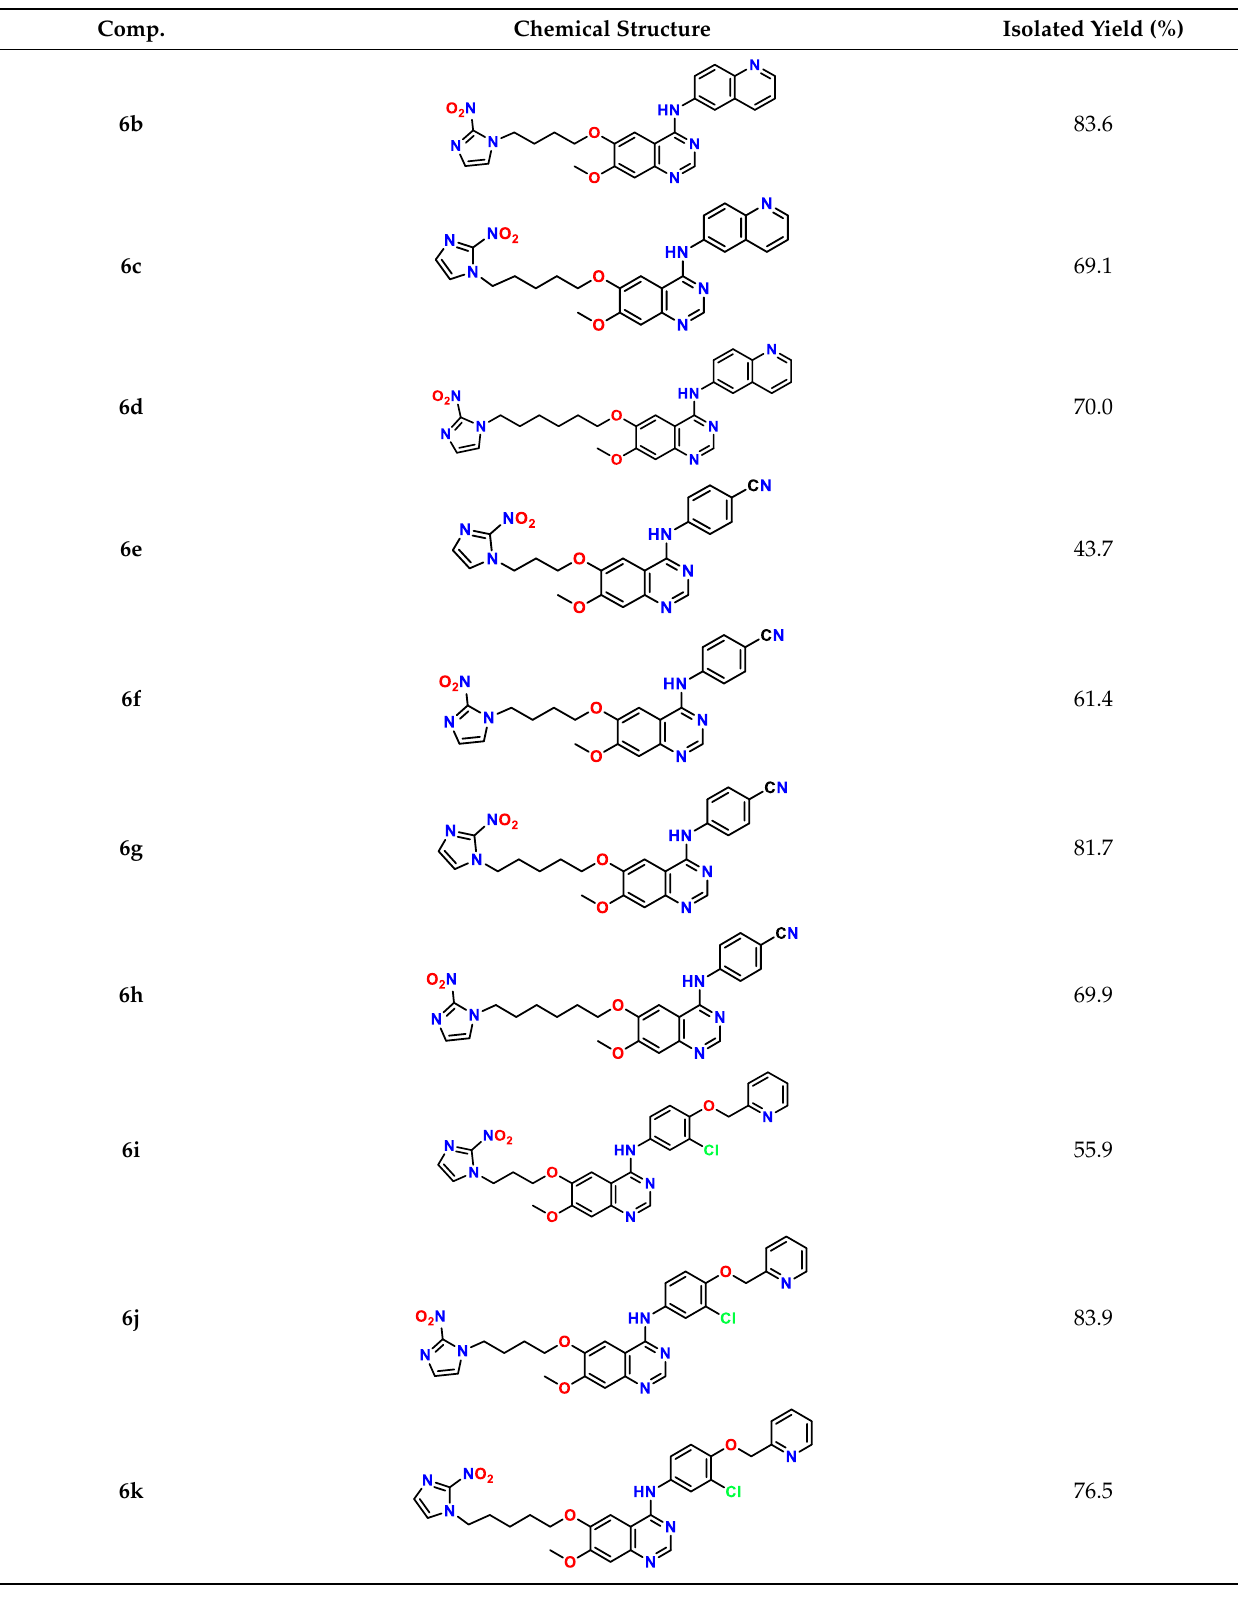
Table 1. Chemical structures and yields of the newly synthesized lapatinib derivatives 6a – l.